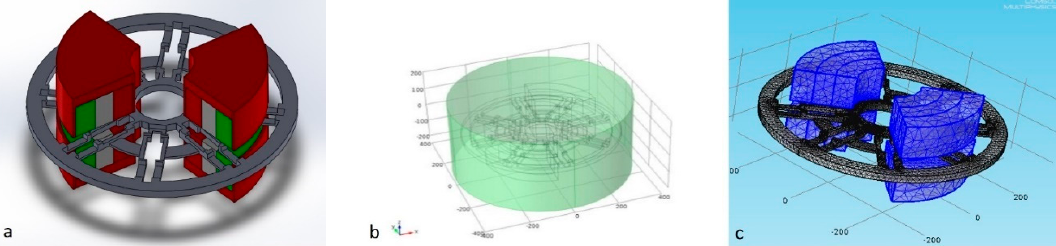
Figure 3. Modelled geometries ( a ), domain of the simulations ( b ), and meshes of magnets and the MCW ( c ).